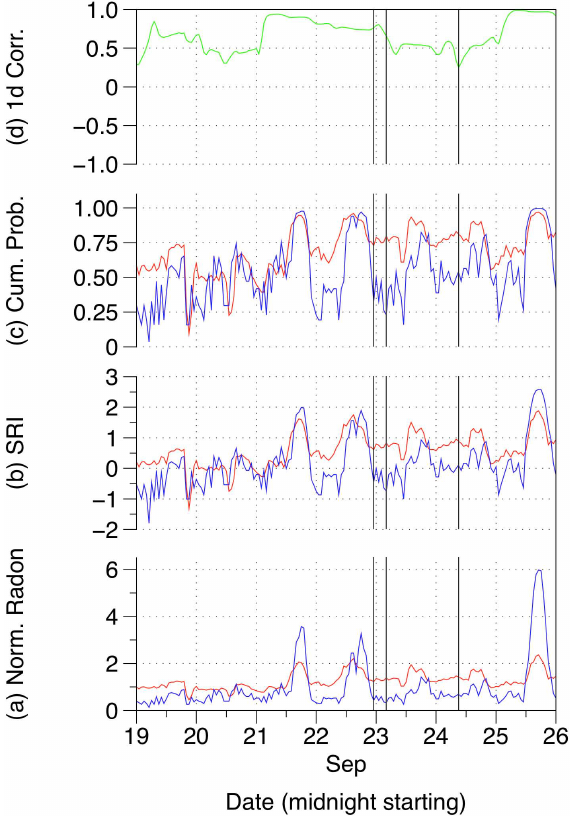
Fig. 3. Late August Radon Anomalies: (a) Normalised Radon, (b) SRI, (c) Cumulative Probability, (d) windowed 1-day correla- tion. TS1a and TS1b are shown in red and blue, respectively, in graphs (a–c) . The vertical grey line shows the timing of the English Channel Earthquake of 26 August 2002.